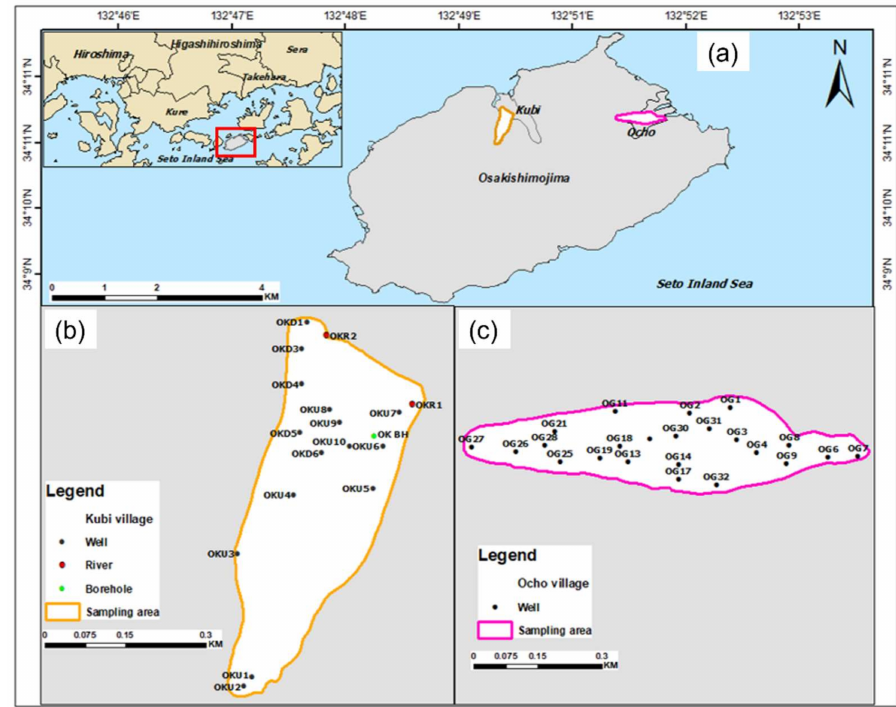
Figure 1. ( a ); Location map of Osakishimojima Island in the Seto Inland Sea showing the sampling points in ( b ); Kubi village and ( c ); Ocho